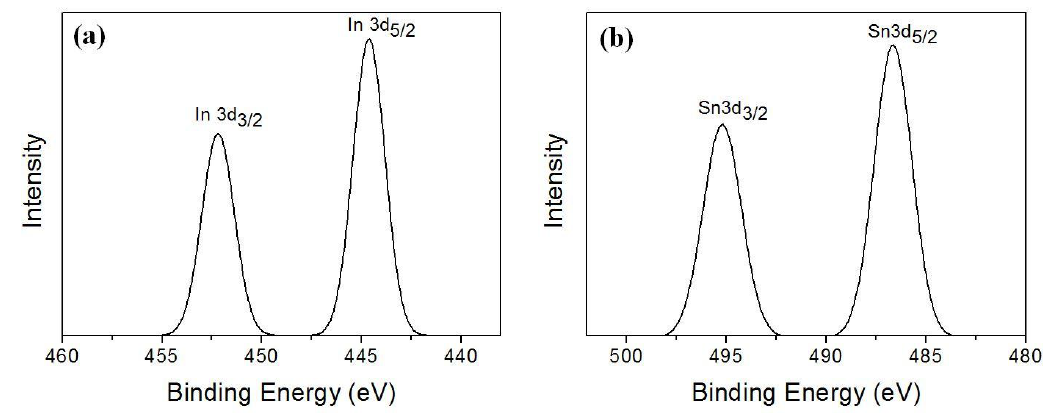
Figure 4. XPS spectra of filter cake part A; ( a ) Indium 3d and ( b ) Tin